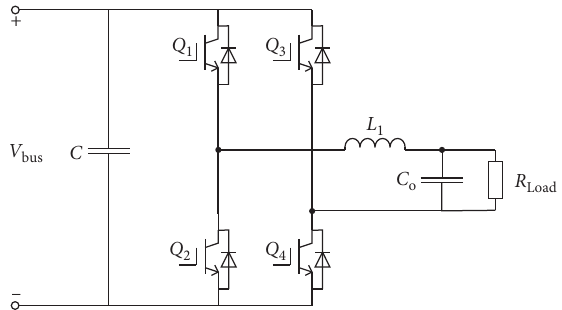
Figure 4: The topology of bidirectional DC/DC